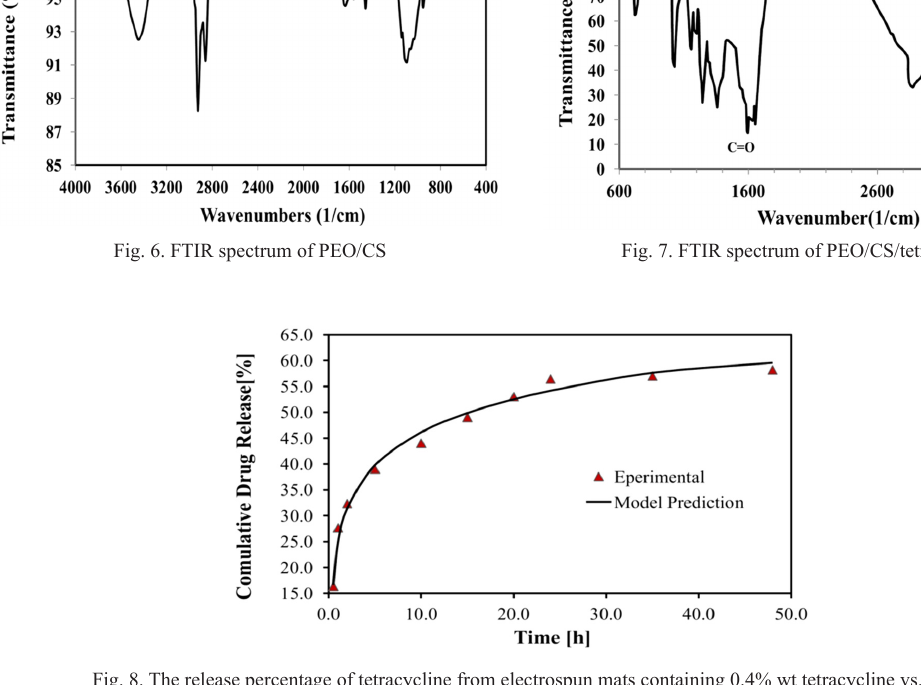
Fig. 8. The release percentage of tetracycline from electrospun mats containing 0.4% wt tetracycline vs. time